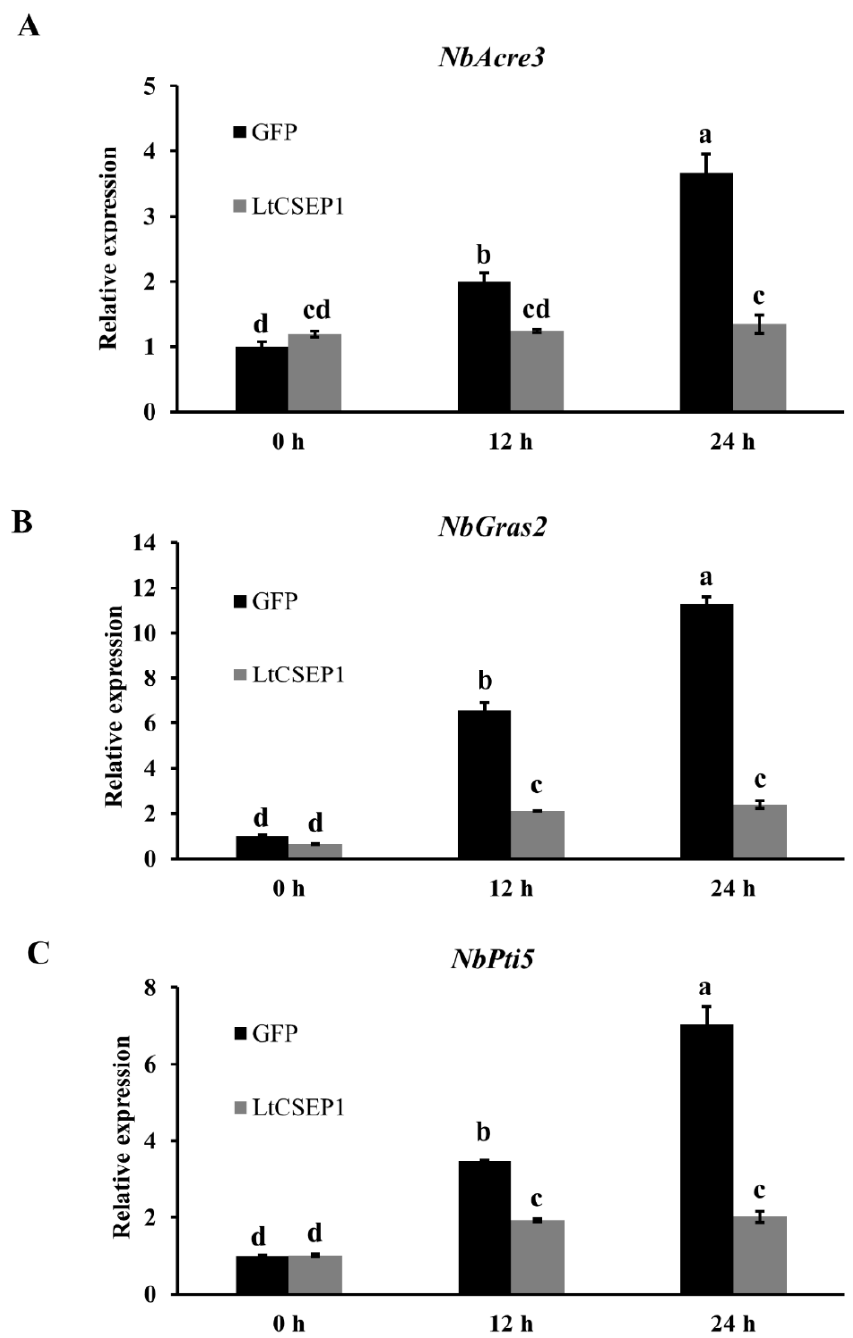
Figure 4. LtCSEP1 suppresses flg22-induced upregulation of PTI-associated genes in Nicotiana benthamiana . ( A – C ) The expression of three PTI-associated genes NbAcre31 ( A ), NbGras2 ( B ), and NbPti5 ( C ) in N. benthamiana leaf tissues expressing LtCSEP1 or the negative control GFP after the treatment of flg22 was determined using qRT-PCR, respectively. The expression level of NbEF1 α was used as an internal reference. Error bars indicate the mean values of three independent biological repetitions with standard errors. Different letters represent significant differences ( p < 0.05).